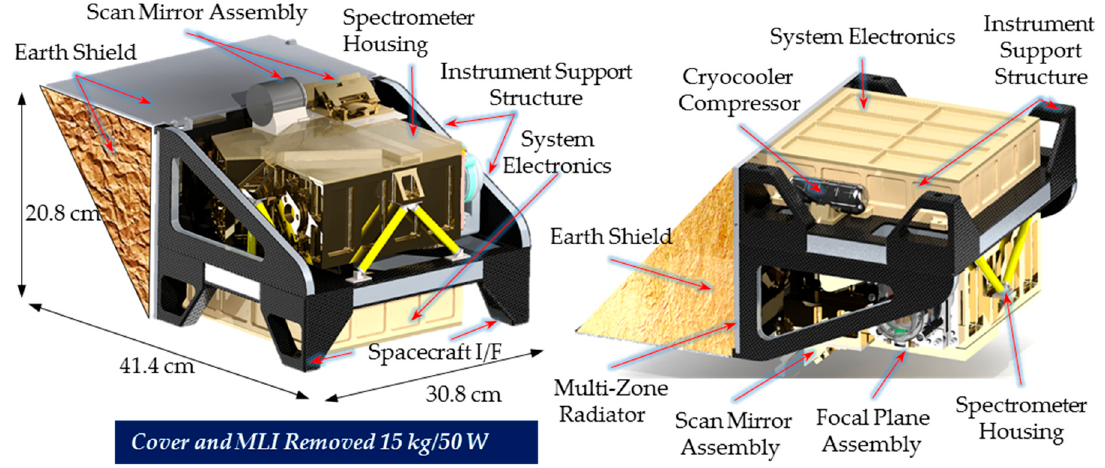
Figure 3. MISTiC Winds IR instrument concept, shown with nadir up ( left ) and down ( right ).